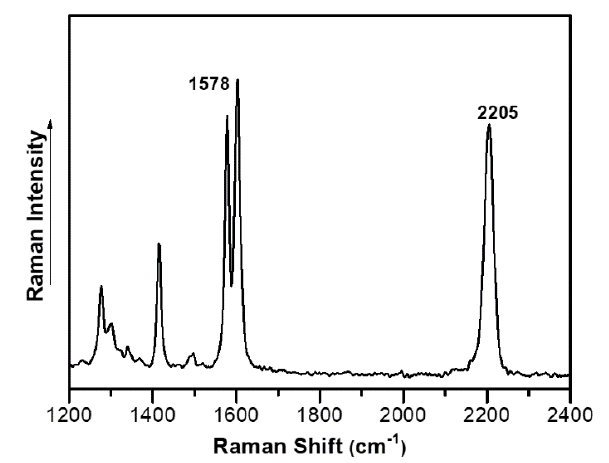
Figure 5. Experimental FT-Raman spectrum for P2b .